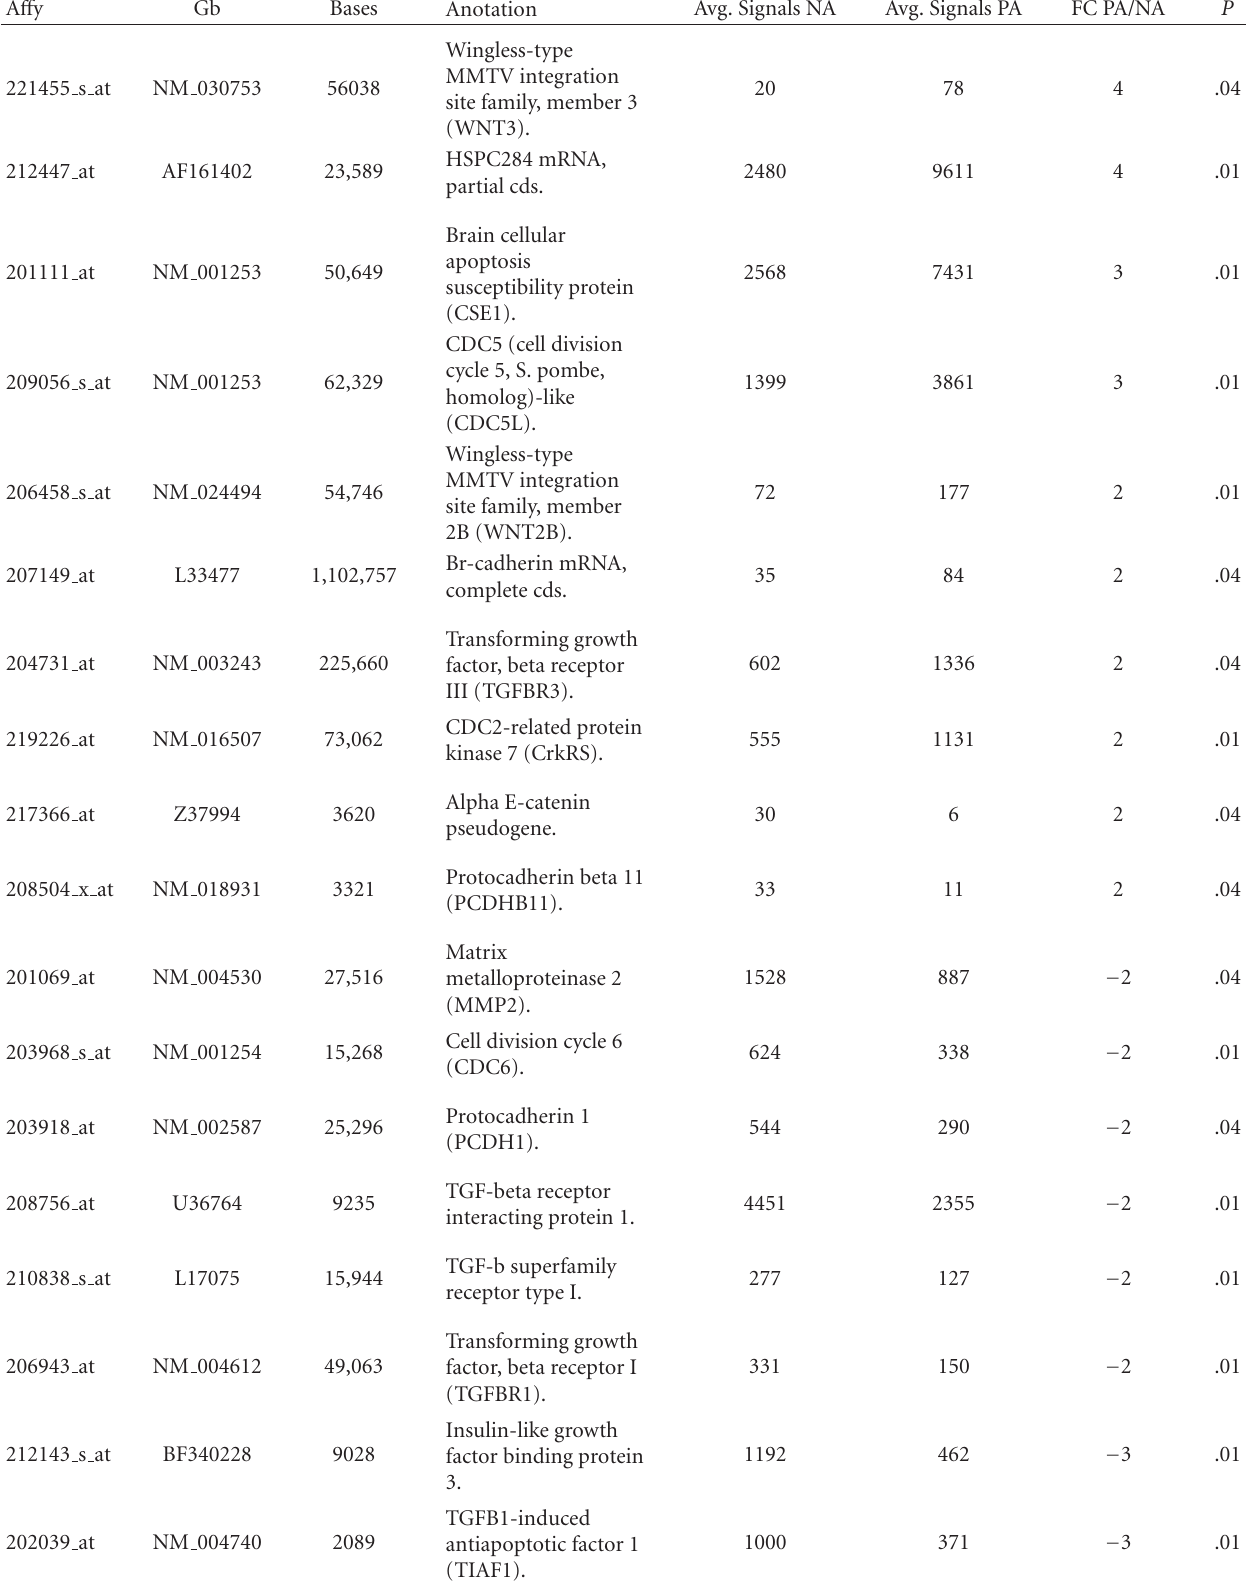
Table 2: Di ff erent gene expression values of cancer specific genes between non amplified (NA) and amplified (PA) RNA samples from colorectal carcinoma